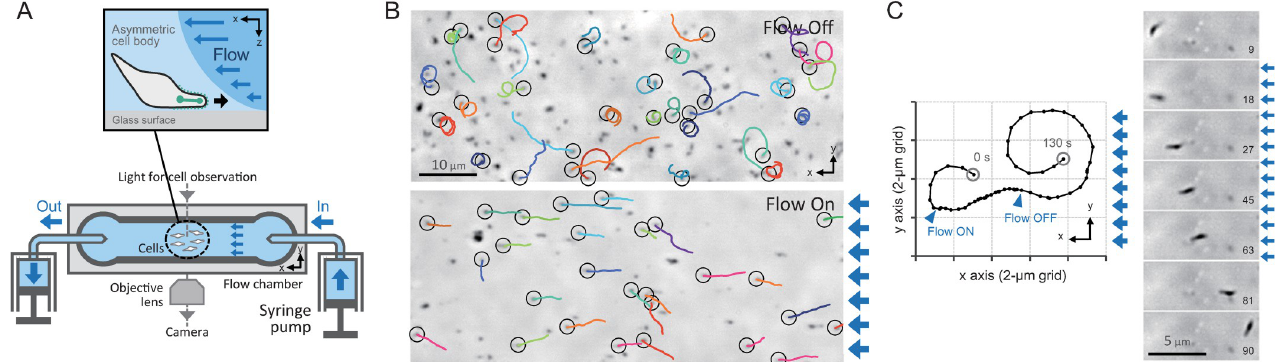
Fig 1. Rheotactic behavior of M . pneumoniae . (A) Experimental setup. Cells were poured into a flow chamber connected to a syringe pump. Precisely controlled fluid flow was applied from the right side in the following images, and the cell behaviors were observed under phase-contrast microscopy. Left upper : Schematic of positive rheotactic behavior. A cell adheres to the glass surface at the attachment organelle and moves over the surface in an upstream direction against the fluid flow. (B) Field image of the rheotactic behavior. Cell trajectories for 40 s (color lines) are plotted on the phase-contrast images. The start position of a trajectory is marked by the black circle. The blue arrows on the right side of the image represent the direction of the fluid flow. Upper : No fluid flow. Lower : Fluid flow at 1.7 mm/s. (C) Single-cell trajectory. Left : Moving trace at 2-s intervals. Arrowheads indicate cell positions at the start and the end of fluid flow. Right : Time-lapsed image. Each time point is presented at the bottom right of the image.